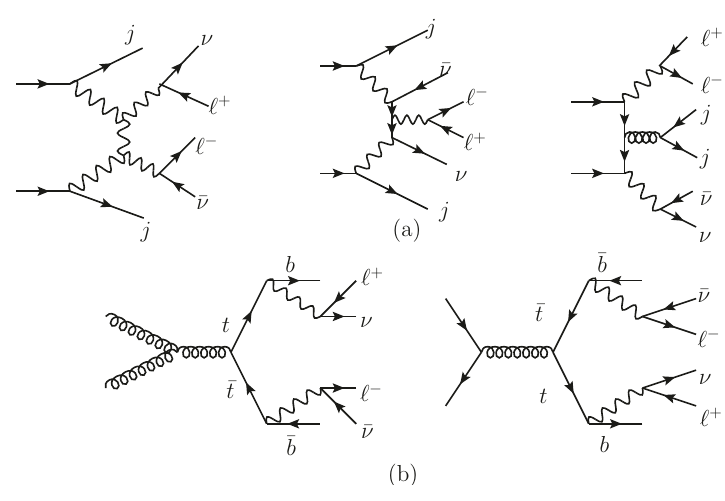
Figure 12 . The typical Feynman diagrams of the